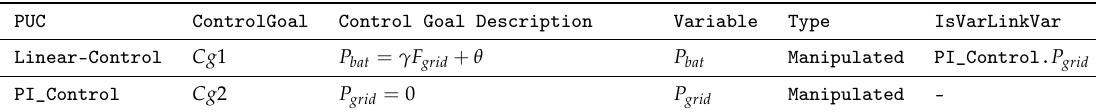
Table 15. Information to detect conflict C I .